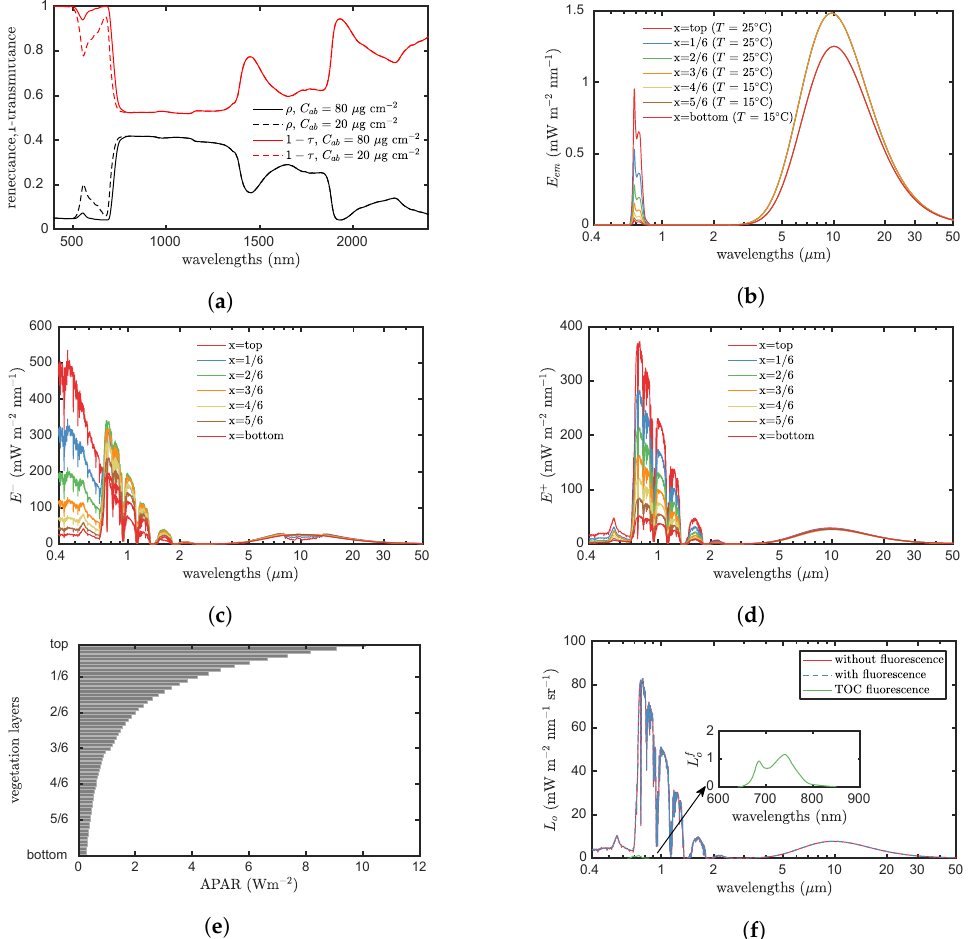
Figure 4. Illustration of the capability of the unified four-stream radiative transfer theory in the spectral region from 0.4 to 50 µ m. ( a ) Leaf reflectance and transmittance of the leaves in the two layers. ( b ) Vertical profiles of fluorescence and thermal emission. ( c ) Vertical profile of downward diffuse flux. ( d ) Vertical profile of upward diffuse flux. ( e ) Vertical profile of photosynthetically active radiation (PAR) absorbed by chlorophyll. ( f ) Radiance in the viewing